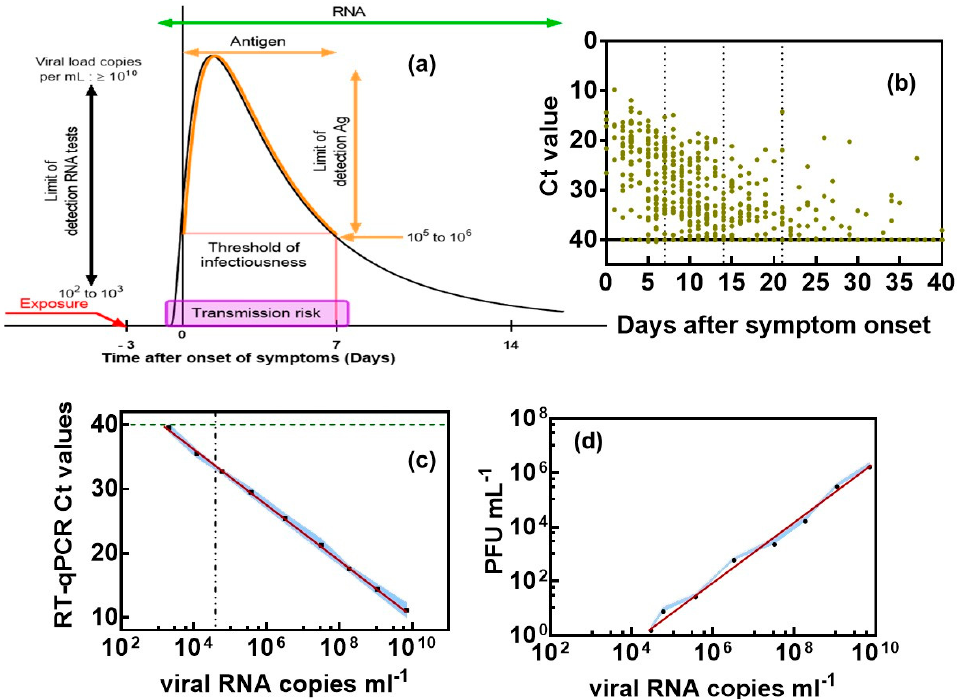
Figure 1. Clinical significance of Ct values and correlation with viral RNA copies as well as plaque- forming units (PFU): ( a ) Timeline of SARS-CoV-2 infectivity taking into account our own findings and those of others [12,14]. ( b ) Ct values as a function of time after symptom onset in nasopharyngeal swab specimens of COVID-19 patients. ( c ) Correlation of Ct counts with viral RNA copies. ( d ) Correlation of viral RNA copies mL − 1 with plaque-forming units (PFU) of SARS-CoV-2 as a measure of infectivity. Vero E6 cells were infected with 10-fold dilutions of a SARS-CoV-2 isolate clade 20A.EU2 (EU variant). Calculation of estimated virus concentration was carried out by the Spearman and Karber method and expressed as TCID50/mL (1 pfu mL − 1 = TCID50/mL × 0.7). The results are expressed as the mean ±SEM of at least three independent measurements for each group.